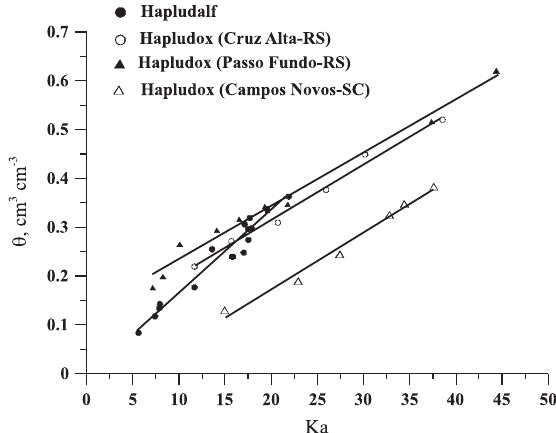
Figure 4. Relation between the dielectric constant (Ka) measured with the TDR-100 and the volumetric soil moisture ( θθθθθ ) determined and calculated by the linear and polynomial models.